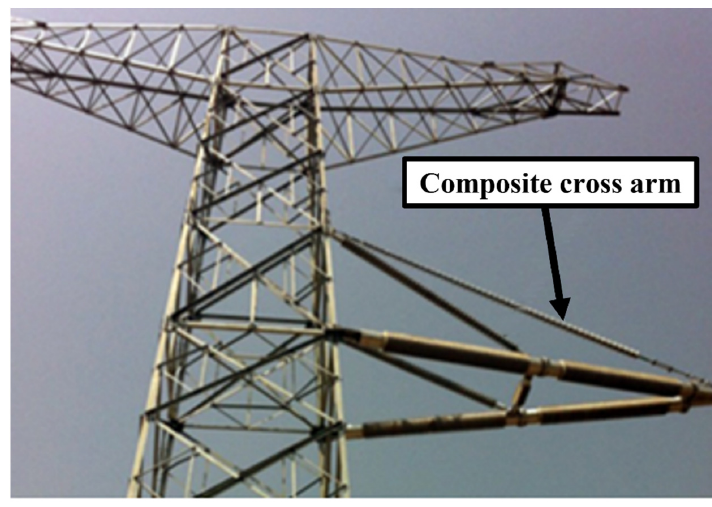
Figure 15. Picture of 750 kV composite cross ‐ arms [37].